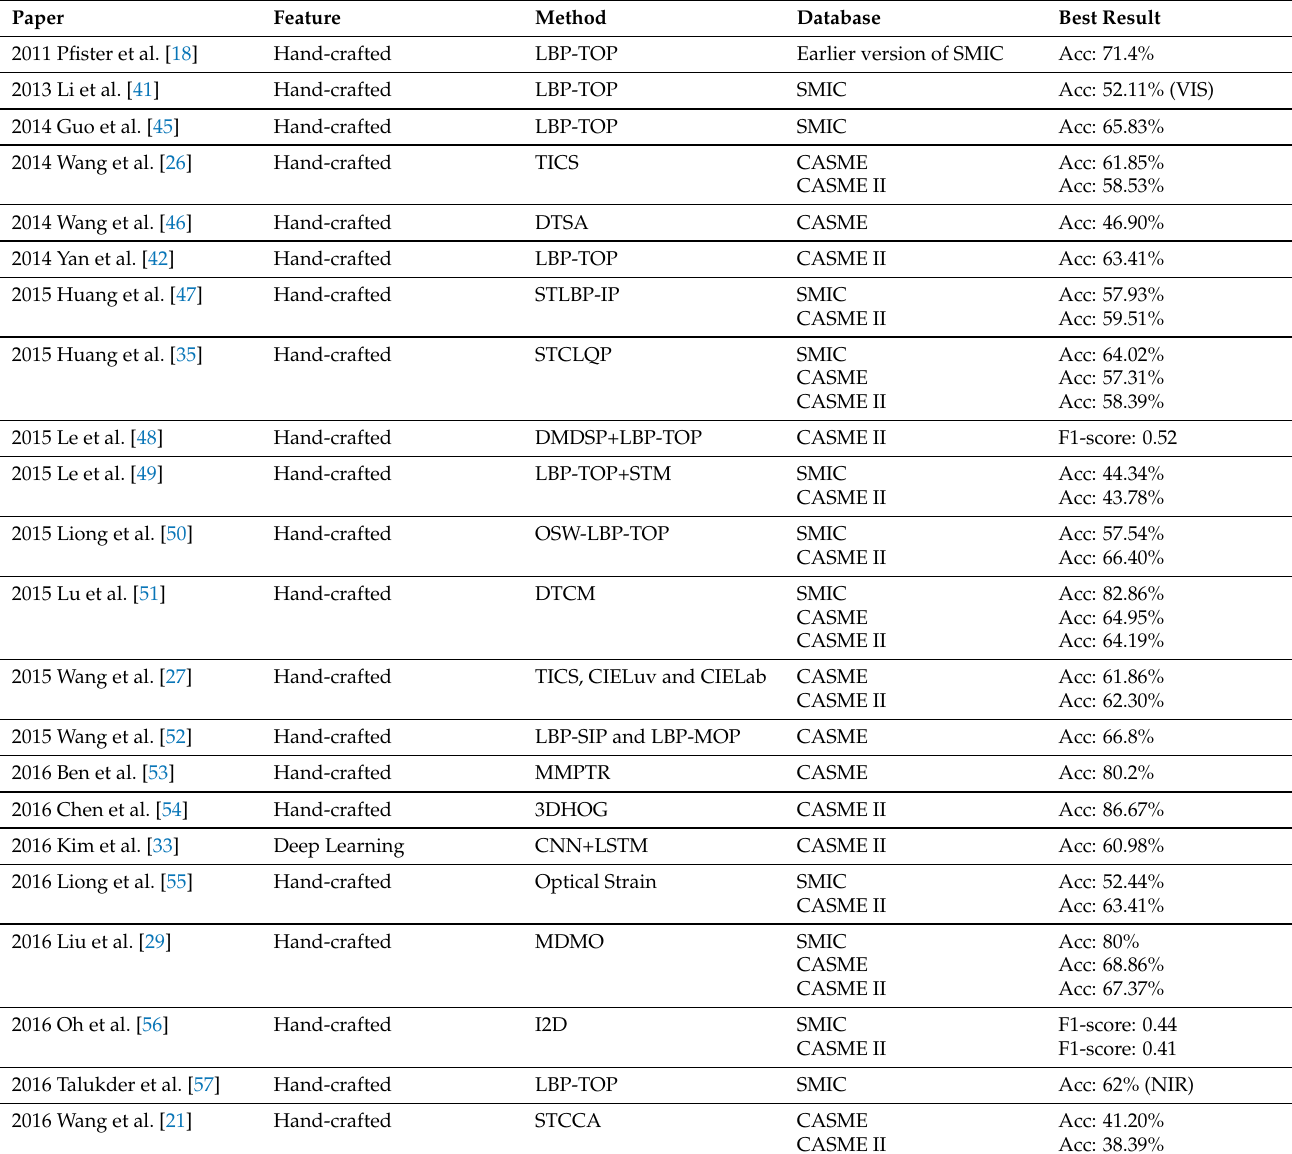
Table A1. Partial Summary of Microexpression Recognition Work on Spontaneous Databases from 2011 to